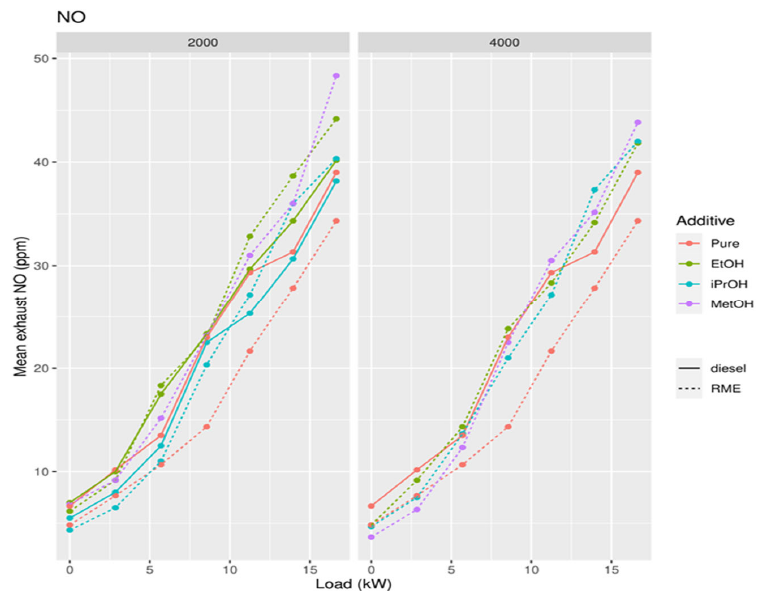
Figure 11. Concentration of NO in exhaust gases in function of the power of the diesel generator after addition of 2000 and 4000 ppm of methanol, ethanol, and isopropanol to biodiesel.